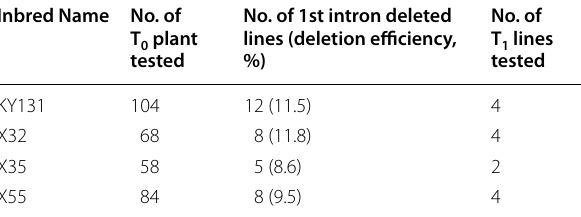
Table 1 CRISPR/Cas9-mediated target deletion of Wx 1st intron Inbred Name No. of T 0